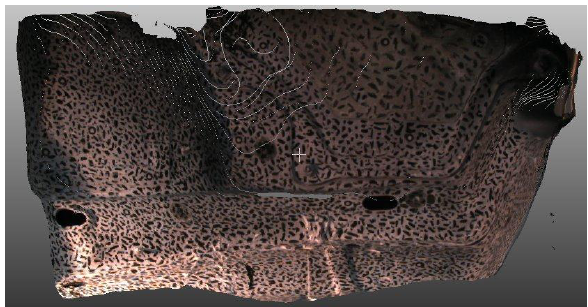
Figure 7. Result of data fusion and dense monoplotting of a footwell